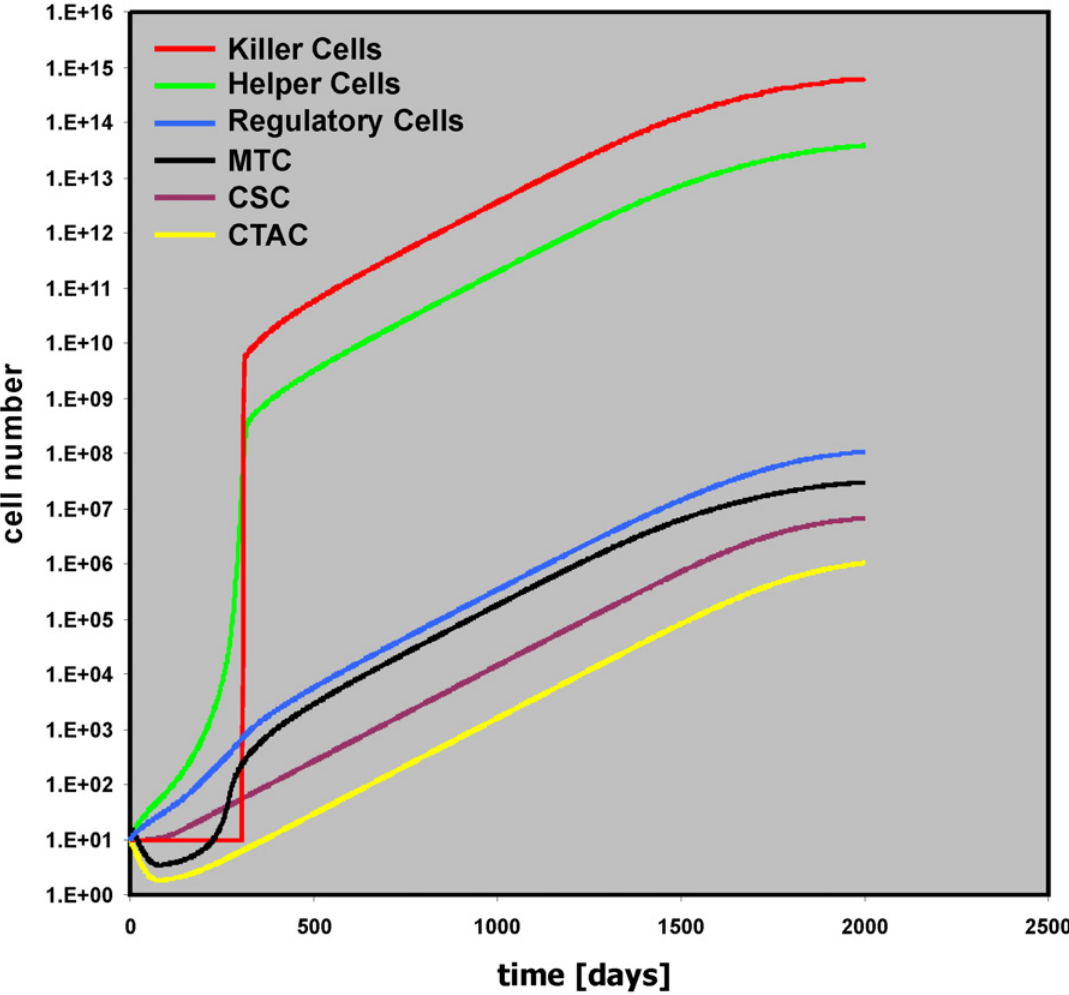
Fig 4. Tumor dynamics with default values of the model. Presented are time courses for all 6 cell populations with default values (see Table 1) of the model. With these default parameters massive tumor growth